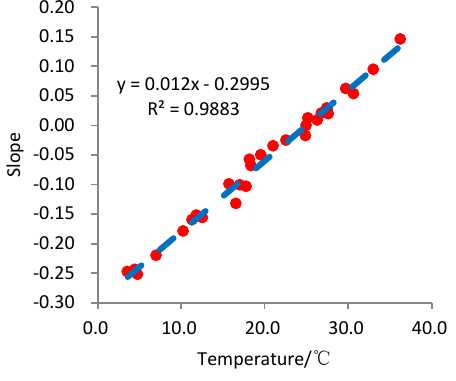
Figure 8: CTE of the Dashengguan bridge estimated with the 29 Sentinel-1A SAR measured